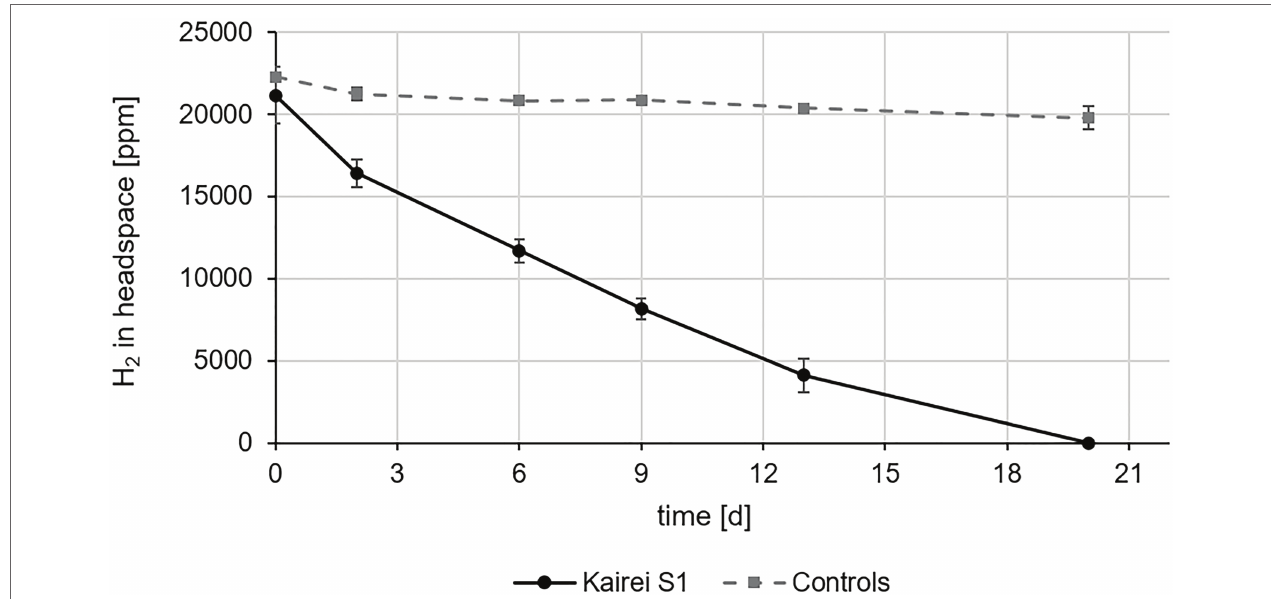
FIGURE 5 | In vivo hydrogen consumption of strain KaireiS1 grown chemoautotrophically with hydrogen as electron donor and sulfate as electron acceptor. A control experiment was set up to exclude hydrogen leakage from the vessels. Error bars indicate the standard deviations from three independent